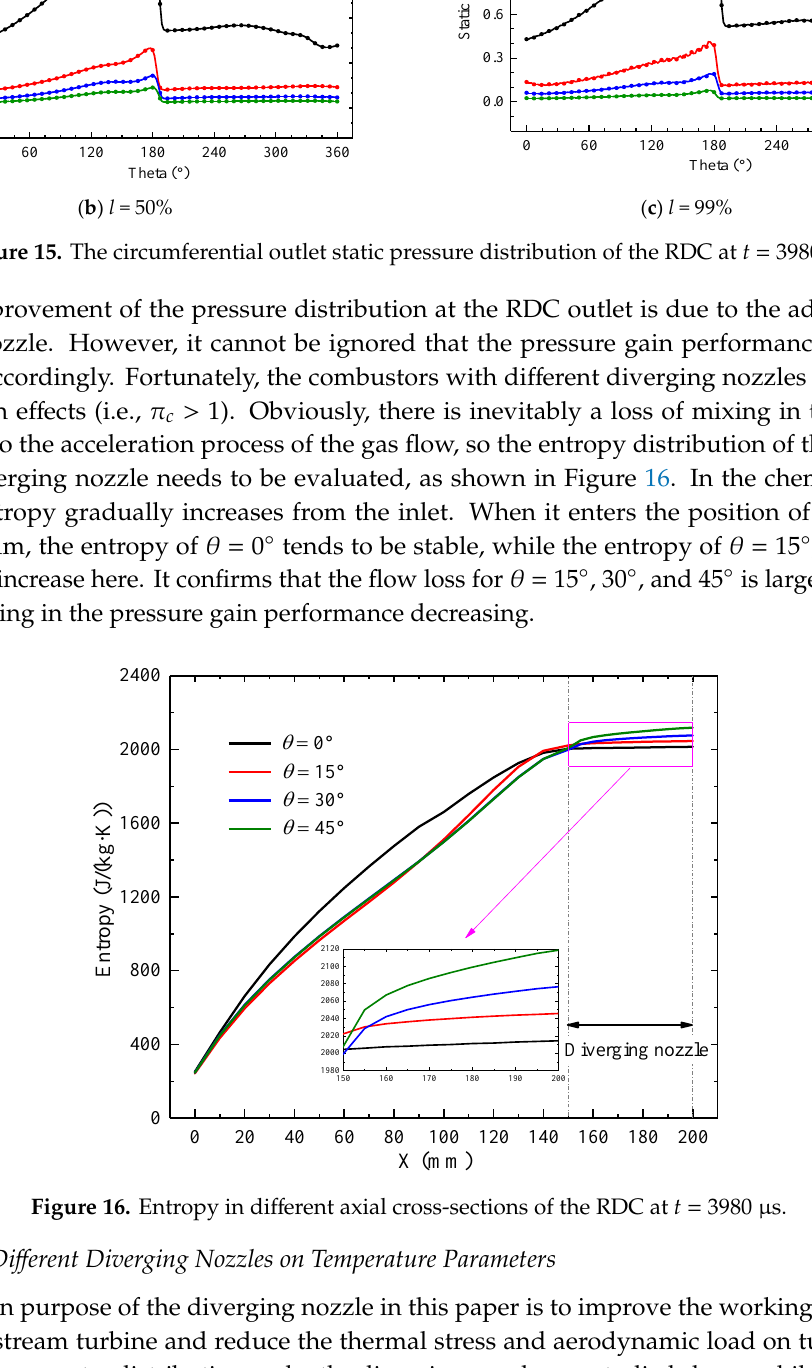
Figure 16. Entropy in different axial cross-sections of the RDC at t = 3980 μs.